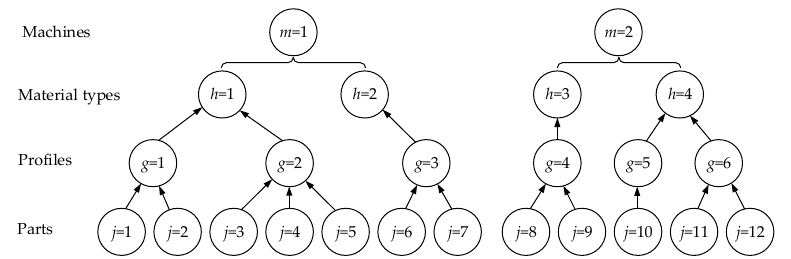
Figure 3. Subordination relationships among parts, profiles, materials and machines.